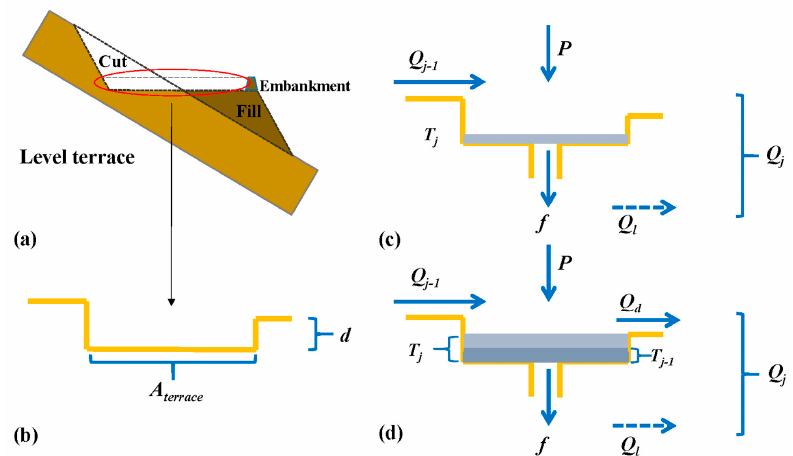
Figure 4. Schematic diagram of flow direction of ( a ) natural hillslope, and ( b ) the hillslope with vegetation and terrace practice. Numbers in the grid are elevations. Orange represents natural hillslope unit. Green represents vegetation unit. Yellow represents terrace unit. Arrows represent flow direction.